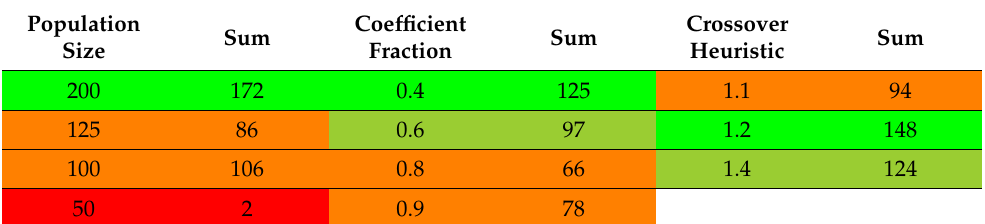
Table 5. Sum of correct results using specific GA parameters. Colour code: Green → the best;